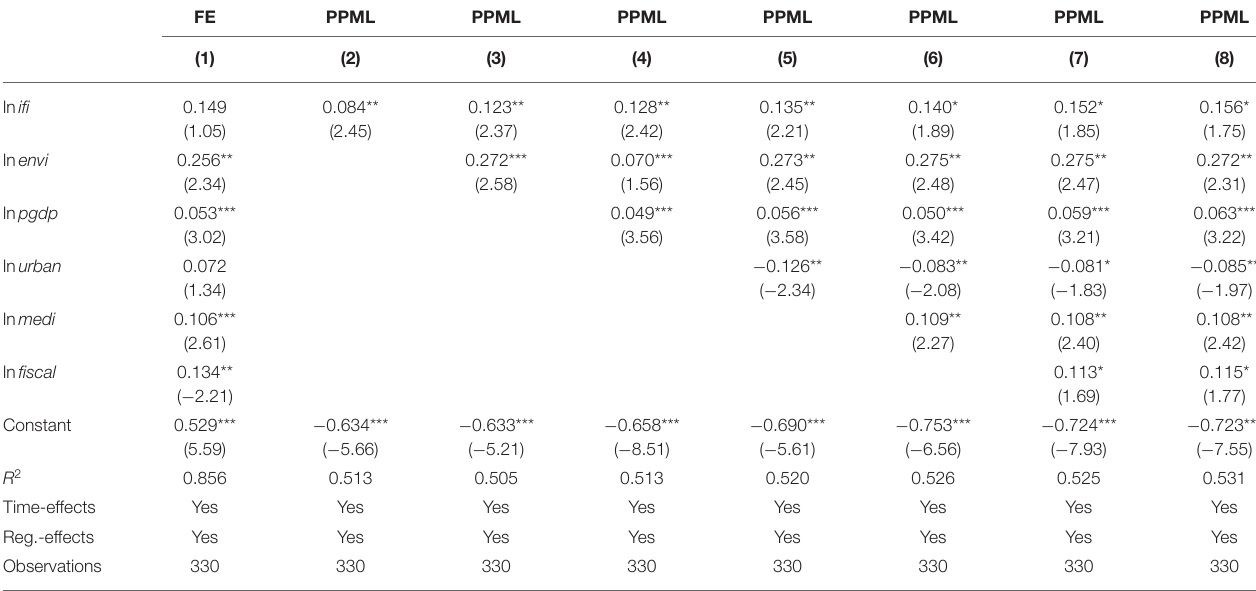
TABLE 1 | Regression estimation results of inclusive finance on public health.